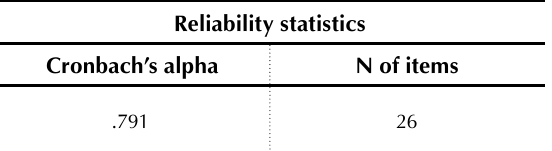
Table 1. Reliability testing on the items measuring the barriers to effective VCM Reliability statistics